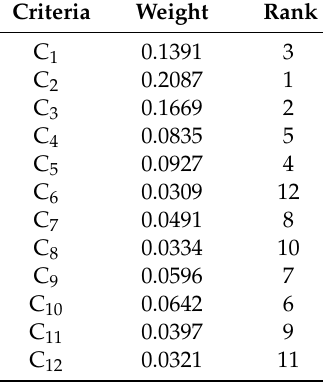
Table 10. Criteria weights (LBWA).